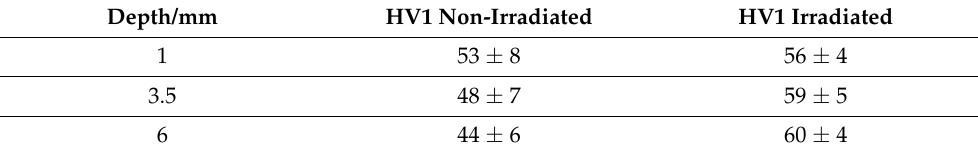
Table 5. Average hardness and its standard deviation of Al-B 4 C MMC at given depths.